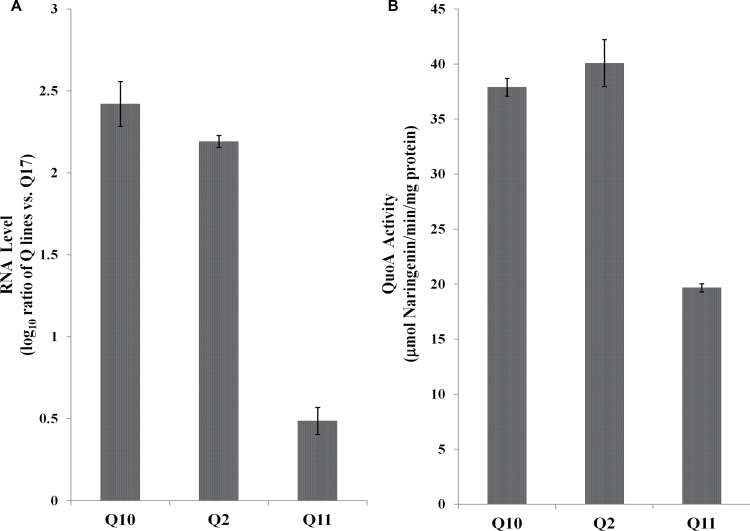
Expression and activity of P. putida PML2 QuoA transgene in Arabidopsis 5-week-old plants. (A) Levels of QuoA transcripts measured by quantitative real-time PCR in selected independent transgenic plants. Fold change values were normalized based on QuoA RNA levels in Q17, which expresses QuoA at low levels. All QuoA RNA levels were significantly different from each other (P<0.001). (B) QuoA activity in crude protein extract from transgenic lines measured by quantifying levels of naringenin produced by the substrate quercetin. Partially purified protein extract from transgenic plants was incubated with quercetin and the reaction mix. Naringenin levels were measured by ESI-MS and conversion rates were calculated per unit time incubation mg–1 of protein. Basal conversion rates were corrected based on Col-0. All QuoA activity levels were significantly different from each other (P<0.01). Data presented are means±SEM from two independent experiments each with five biological replicates.